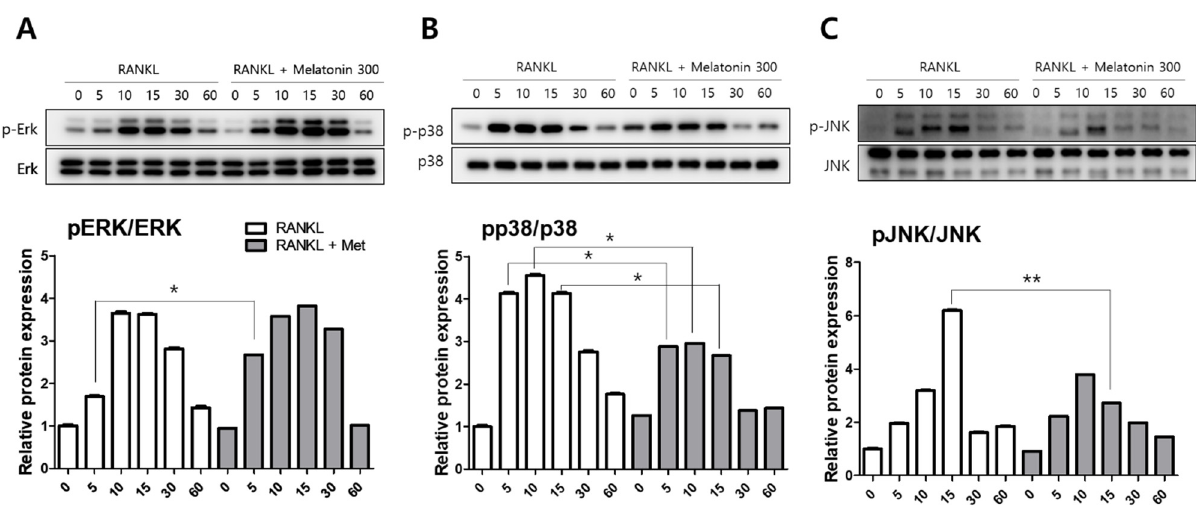
Figure 2. Effects of RANKL and melatonin treatment on MAPK signaling in RAW264.7 cells. Cytosolic protein levels of ( A ) p-ERK, ( B ) p-p38, and ( C ) p-JNK in RAW 264.7 cells treated with RANKL (10 ng/mL) and RANKL (10 ng/mL) + melatonin (300 µ M) for 5, 10, 15, 30, and 60 min according to western blot analysis. The expression data were normalized to the total MAPK (ERK, p38, and JNK) signal. Values represent the means of three independent experiments ± SDs. RANKL alone treatment and RANKL + melatonin combination treatment were verified using a paired sample t -test (* p < 0.05, ** p <0.01).